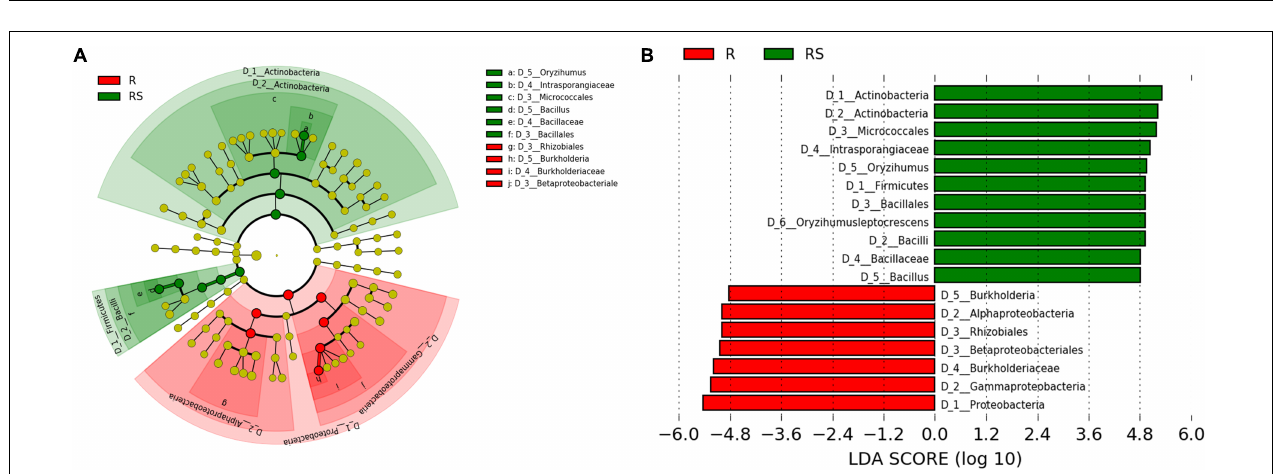
FIGURE 1 | Bacterial communities in the root-associated compartments of sugarcane. Samples were divided into rhizosphere and root samples according to the compartment of origin. Bacterial community composition was determined using 16S rDNA sequencing. Principal coordinates analysis (PCoA) was performed using Bray–Curtis distance (A) and weighted-unifrac distance (B) based on the OTU table. Analysis of similarity (ANOSIM) was performed based on the OTU tables of R and RS samples to calculate differences. In permutation tests, the number of permutations was 999. The composition of microorganisms was analyzed in the rhizosphere at the phylum level (C) and class level (D) . R, sugarcane root; RS, sugarcane rhizosphere; OTU, operational taxanomic unit. (E) Venn diagram of microbes in the rhizosphere and root compartments of sugarcane. (F) Cladogram of top 150 microbes (mean relative abundance) based on taxonomy. OTUs relative abundance of two compartments are shown in the outermost rings of the green and red heat map (root samples as green and rhizosphere samples as blue).